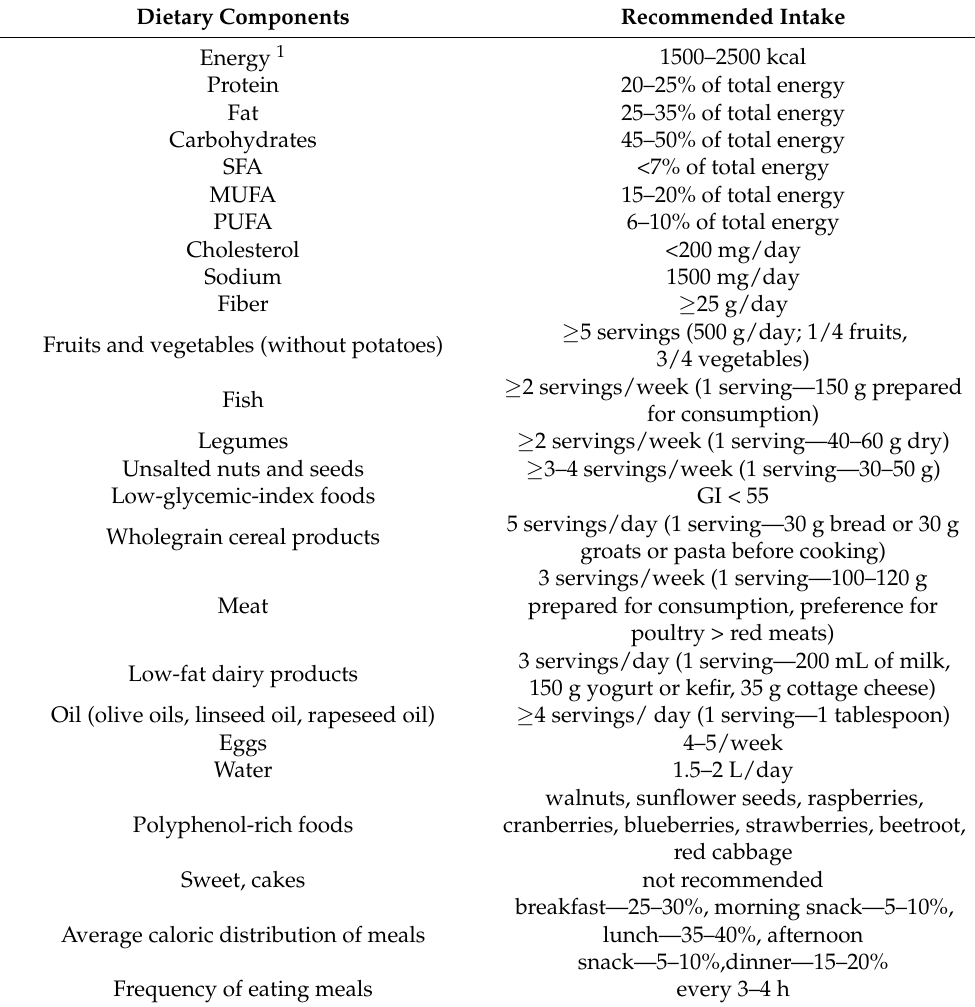
Table 1. Characteristics of the recommended diet